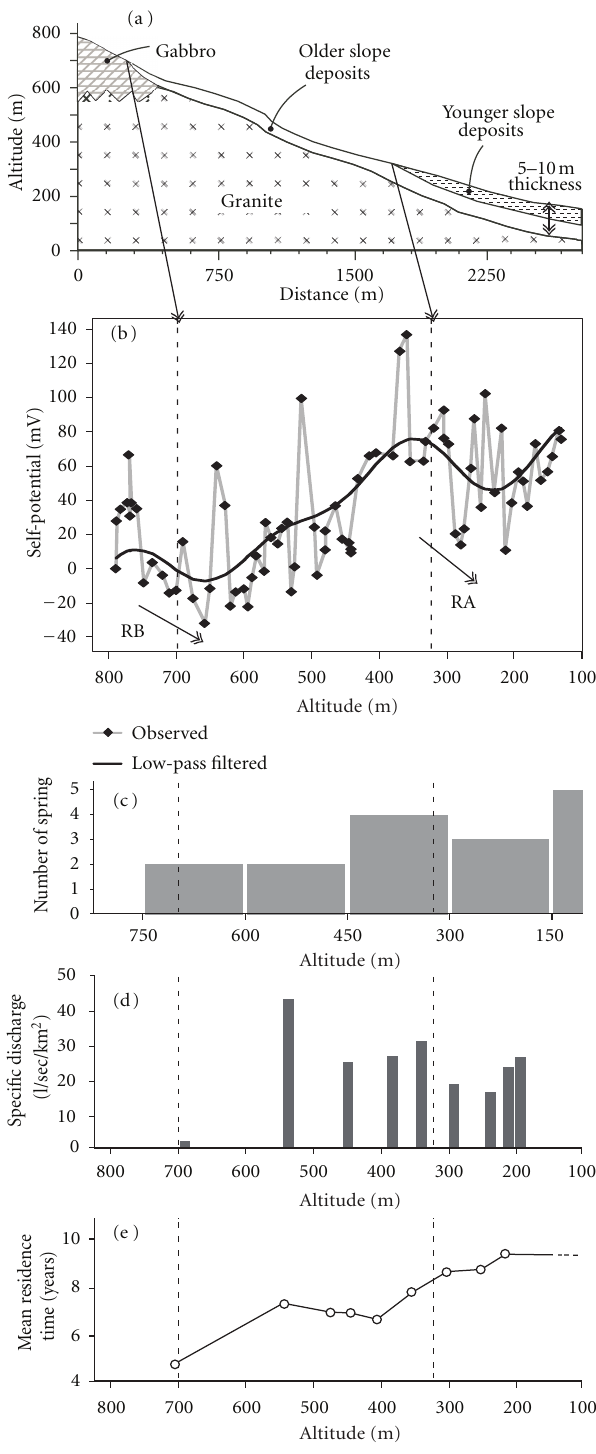
Figure 7: Comparison of the geological setting, SP distributions, and hydrological information along the northern slope of Mt. Tsukuba. (a) Geological structure [20]. Note that the surface layer is exaggerated vertically. (b) Raw and regional SP profiles are same as shown in Figure 5. (c) Histogram for number of springs around Mt. Tsukuba against altitude derived from [23]. (d) Specific discharge of the Ono-kawa river water [22]. (e) Mean residence time of stream water